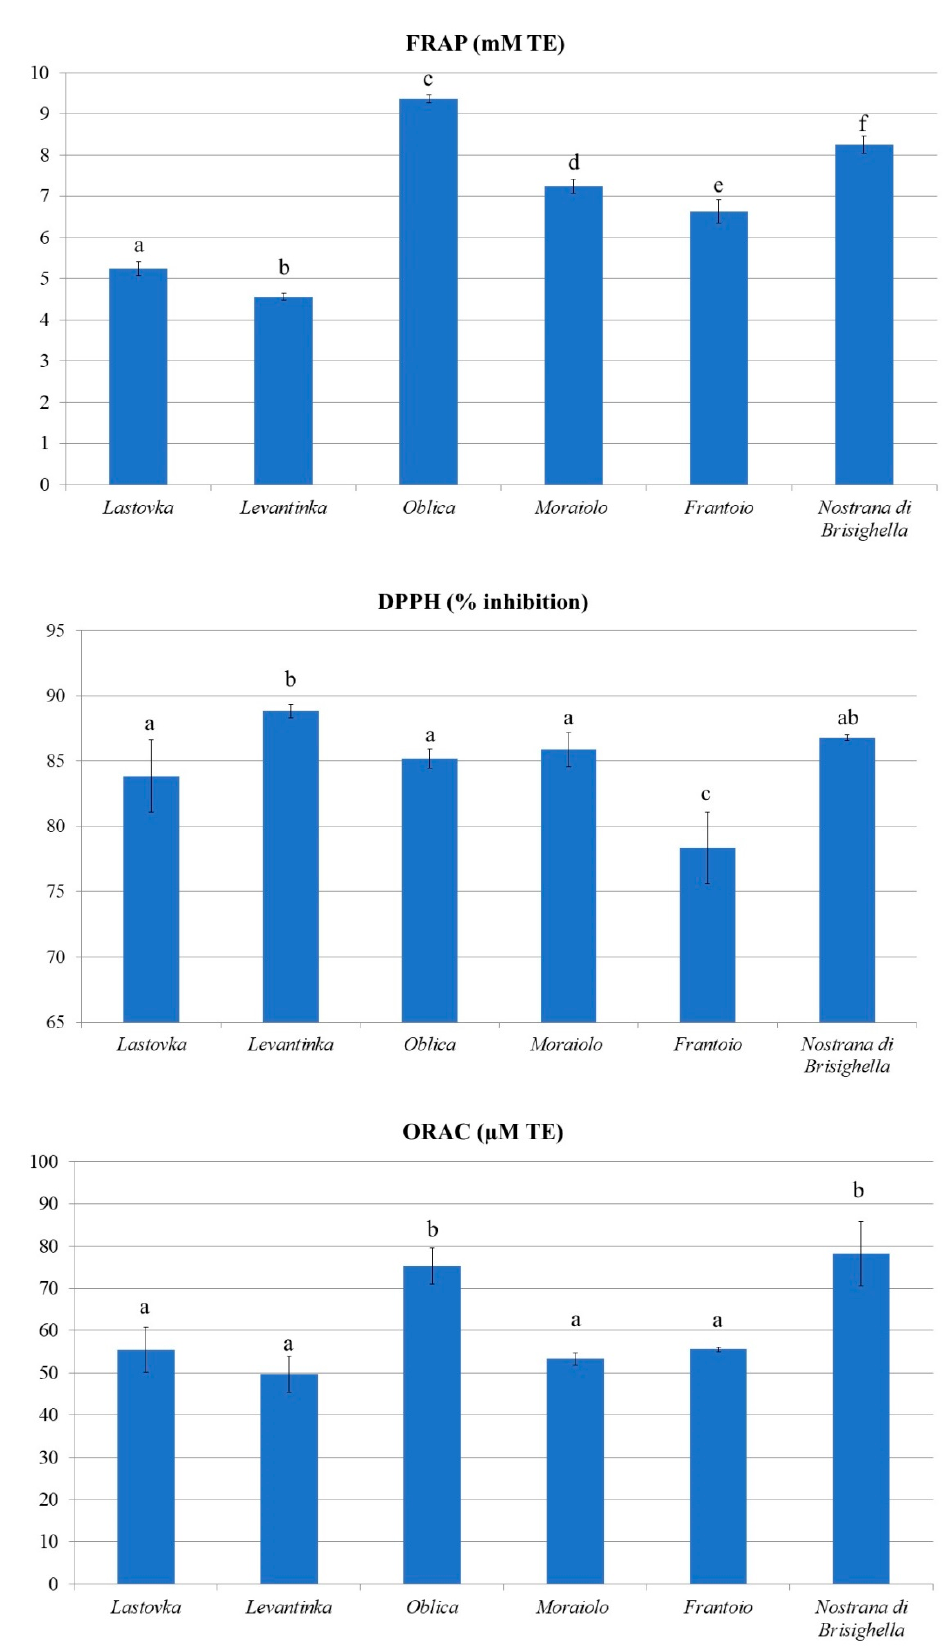
Figure 2. Antioxidant activity of olive leaf extracts detected by FRAP, DPPH, and ORAC method ( n = 4). Columns marked with different letters are statistically different ( p < 0.05).